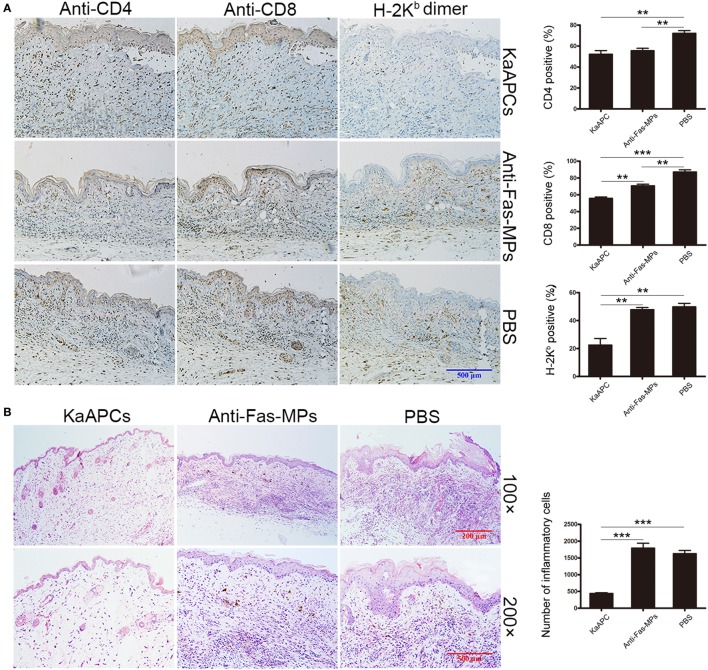
Killer artificial antigen-presenting cells (KaAPCs) reduce the local infiltration of alloreactive T cells and inflammatory cells in allograft. On day 20 posttransplantation (7 days after the final treatment), alloskin grafts were collected from recipients in each treatment group and embedded in paraffin. Allograft sections were prepared. (A) IHC analyses. Sections were incubated with H-2Kb-Ig dimer, anti-mouse CD4, anti-mouse CD8, or IgG2b/isotype control monoclonal antibodies (mAbs) and then stained with biotinylated secondary antibodies followed by visualization using an ABC kit. (B) Hematoxylin and eosin staining. The IHC images were presented at 200× magnifications. Representative sections were selected from three to five individual mice. KaAPCs mean the Kb-KaAPCs co-displaying H-2Kb-Ig dimers and anti-Fas mAbs. **p < 0.01, ***p < 0.001.